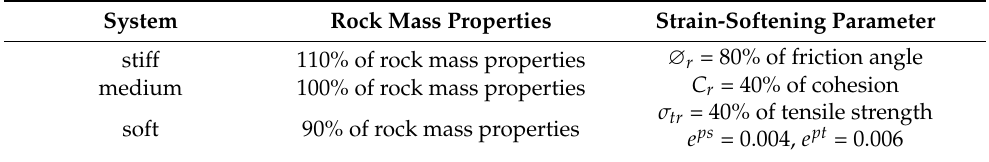
Table 4. Material property values used for rock bolt.